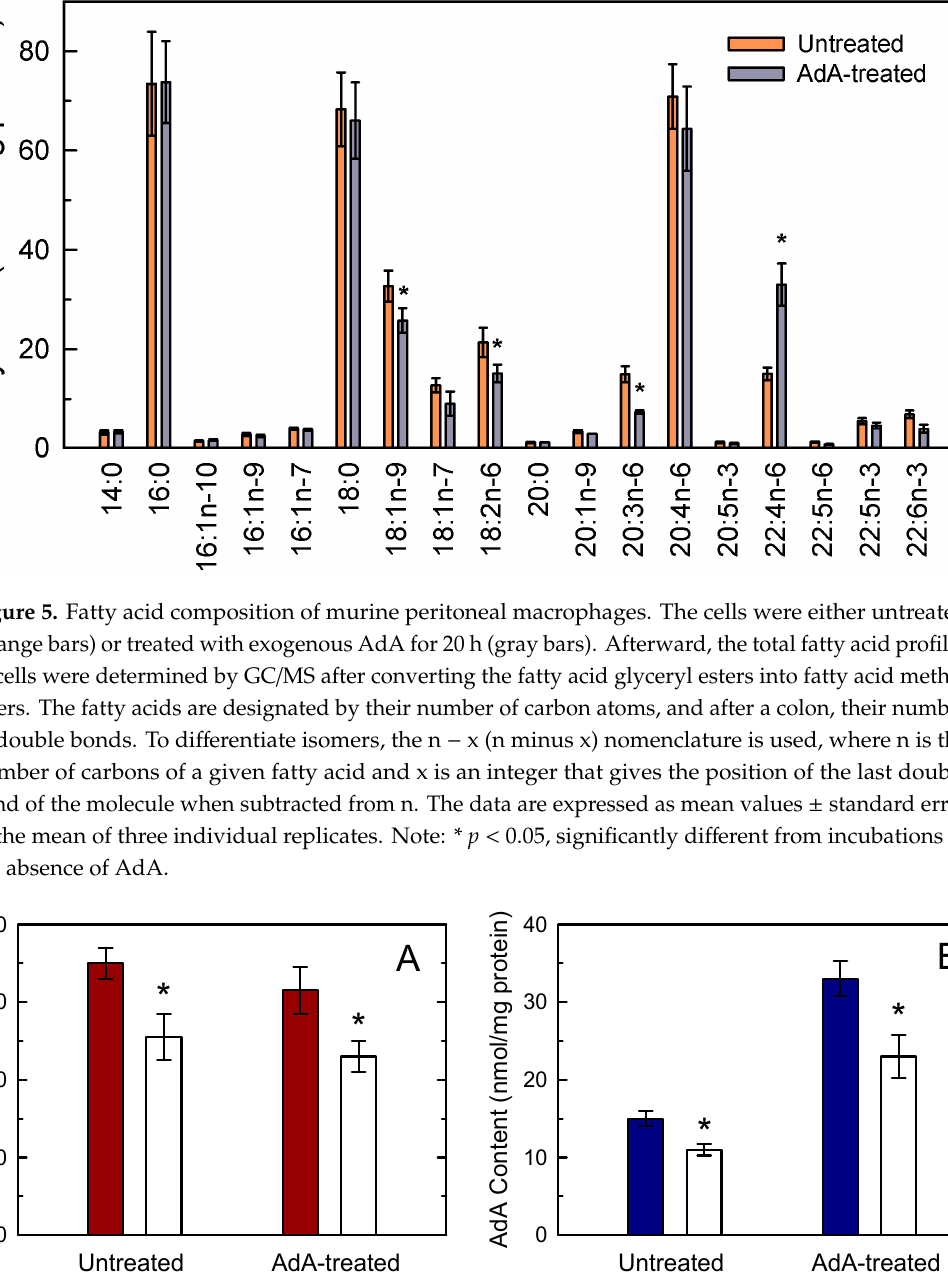
Figure 6. AA and AdA mobilization in zymosan-stimulated macrophages. The cells were either untreated or treated with exogenous AdA for 20 h (see x-axis). Afterward, the cells were unstimulated (colored bars) or stimulated (open bars) with 1 mg/mL zymosan for 1 h, and cellular AA content ( A ) or AdA content ( B ) was determined by GC/MS. Results are shown as mean values ± standard error of the mean ( n = 3). Note: * p < 0.05, significantly different from unstimulated cells. Analysis of AA-derived metabolites produced by zymosan-stimulated cells did not appreciably change whether the cells had previously been treated with AdA or not, while the levels of the only AdA metabolite detected at significant levels in the stimulated macrophages, dihomoprostaglandin